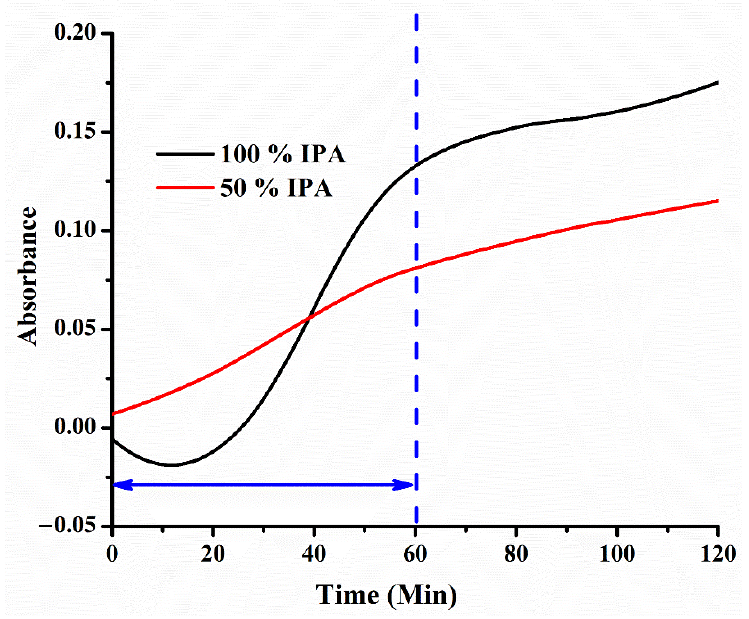
Figure 7. Saturation response of the sensor corresponding to 50% and 100% IPA concentrations.